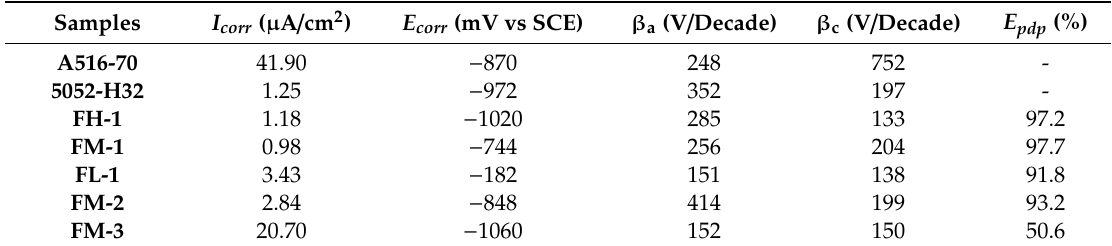
Table 5. Results obtained from the potentiodynamic polarization (PDP) test for bare and cladded